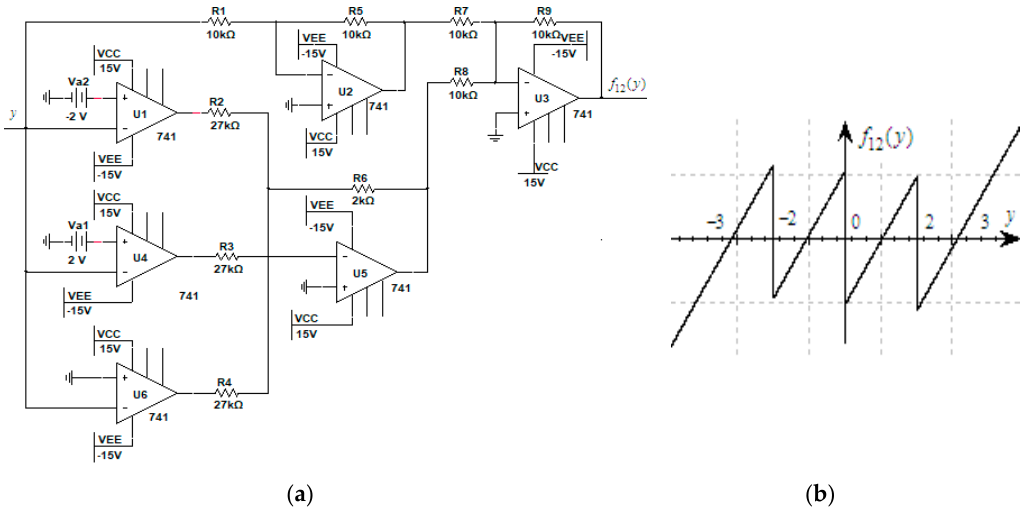
Figure 10. The implement circuit of nonlinear function f 11 ( y ) with N 11 = 0 and B = 1: ( a ) electronic circuit for 3-scroll and ( b ) the corresponding circuit simulation result.